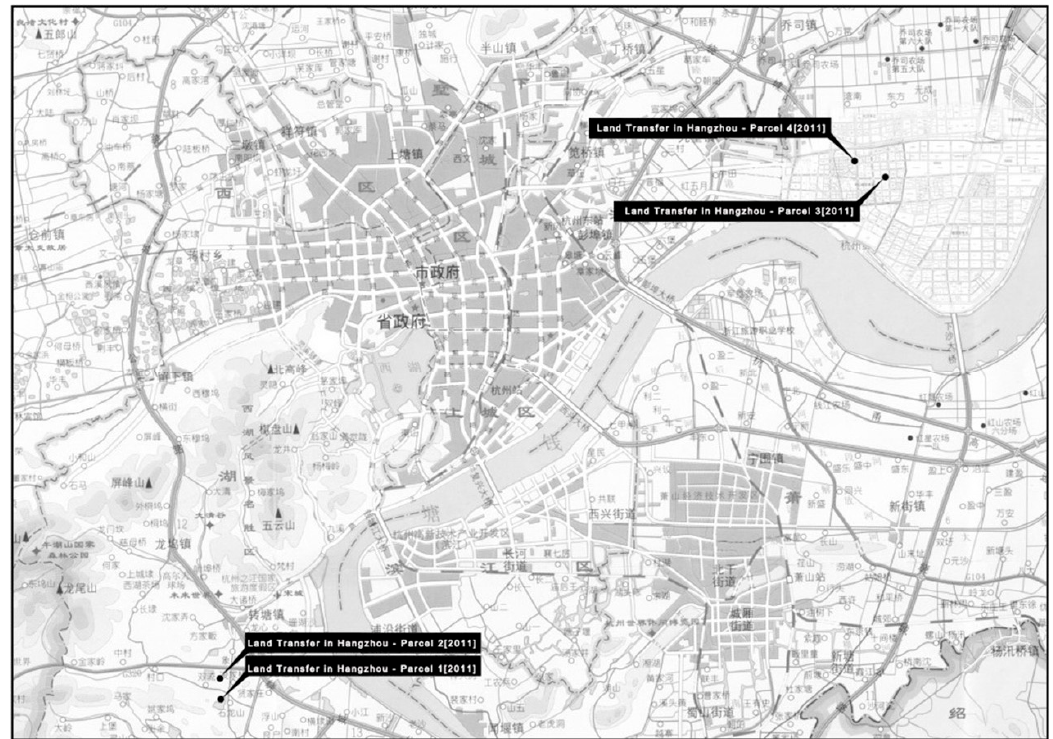
Figure 2. Hangzhou Bureau of Land and Resources announces the case diagram of location of transferred land (Source: house.hangzhou.com.cn accessed on 30 January